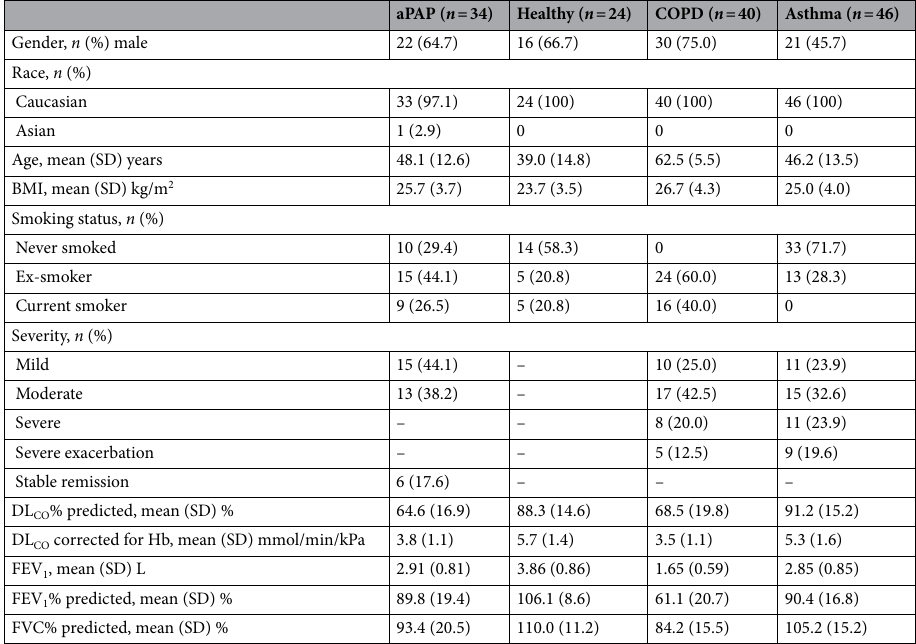
Table 1. Demographic, disease severity and pulmonary function characteristics at baseline. aPAP autoimmune pulmonary alveolar proteinosis, BMI body mass index, COPD chronic obstructive pulmonary disease, DL CO diffusing capacity of the lungs for carbon monoxide, FEV 1 forced expiratory volume in 1 s, FVC forced vital capacity, Hb hemoglobin, SD standard